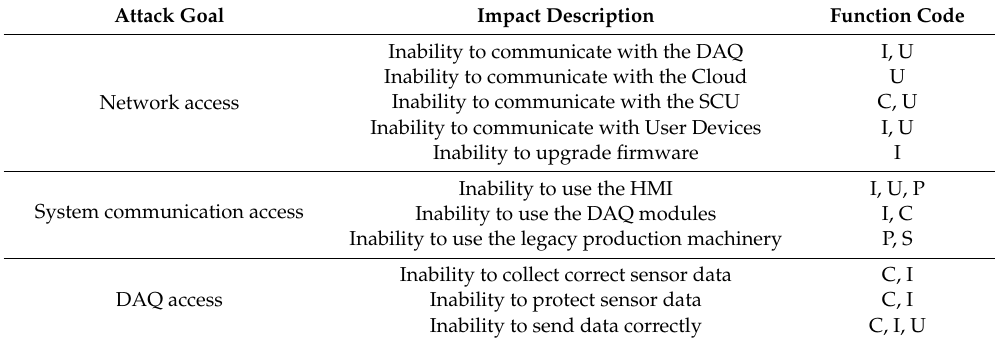
Table 6. Attack goals and impacts. P: Primary; S: Secondary; I: Information; U: